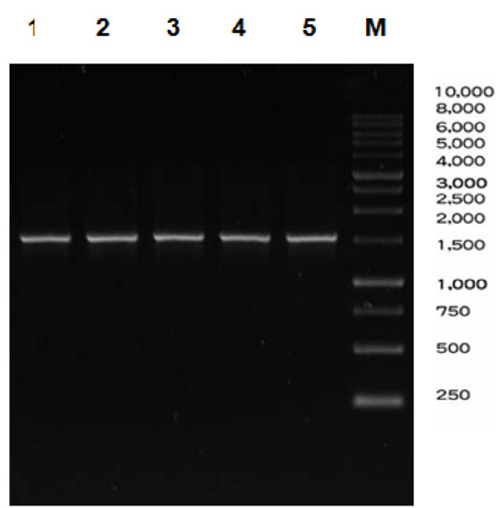
Fig. 1. PCR result of five